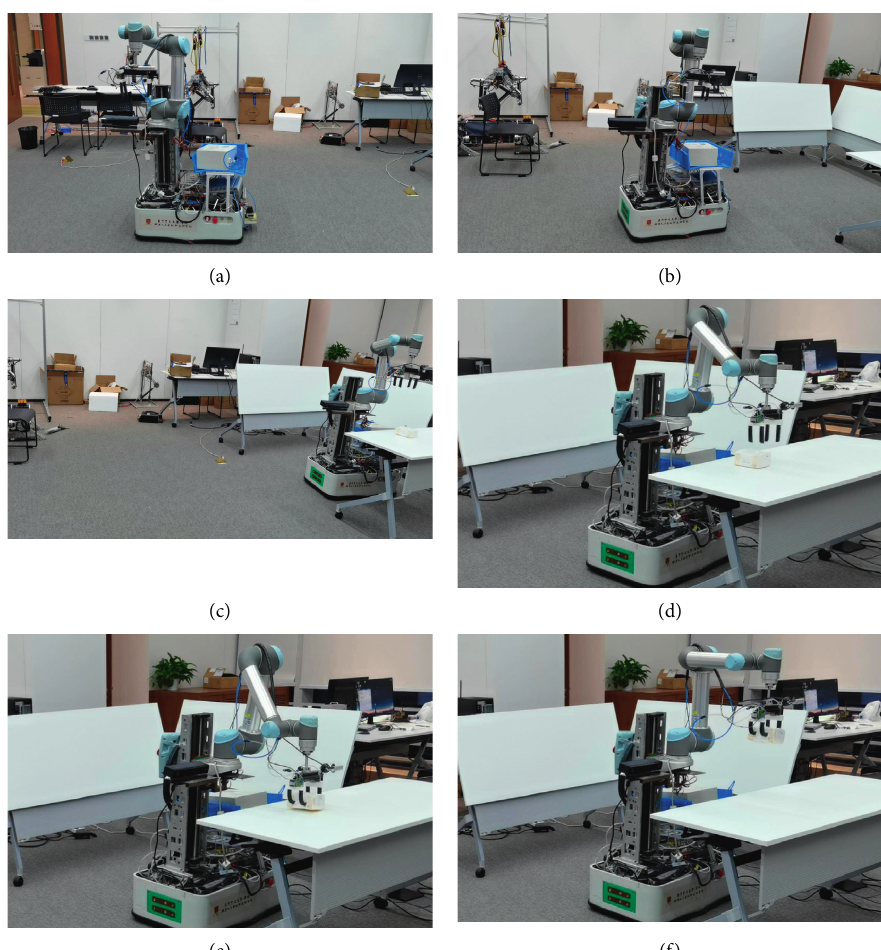
Figure 15: The grasping process of the mobile grasping robot. (a), (b), and (c) move to the destination of the item. (d), (e), and (f) arrive at the destination for grasping.